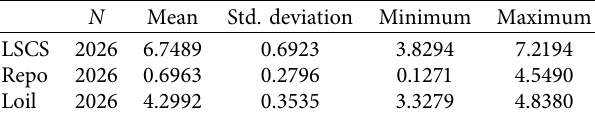
Table 1: Descriptive statistic of Saudi stock market dataset. N Mean Std.